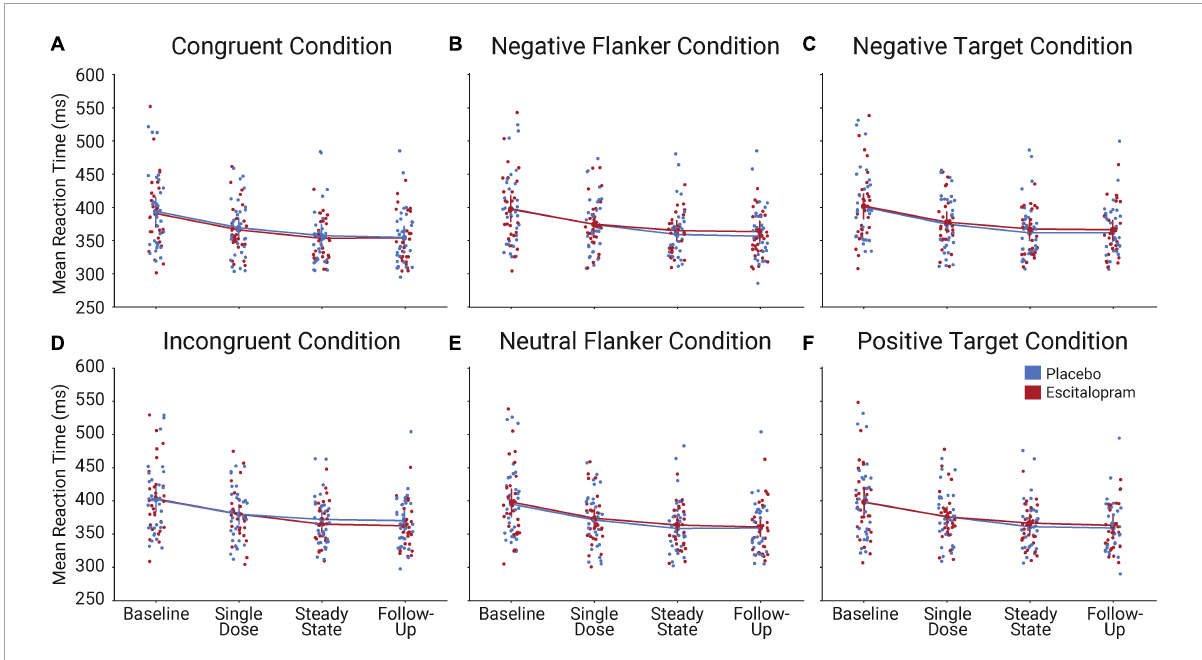
FIGURE3 Timeline of behavioral performance during 1-week of escitalopram-intake and after a 1-month wash-out period for each task condition: We measured RT [in milliseconds (ms)] performance on the mEFT in both the escitalopram and placebo groups at baseline, single dose, after 1-week of continuous intake, and following a 1-month wash-out period. We assessed performance in each of the (A) congruent and (B) incongruent conditions, (C) the negative and (D) neutral flanker conditions, and (E) the negative target and (F) positive target conditions. While results indicate a significant effect of time, with decreasing RT between the baseline and follow-up assessments, we did not observe any indication of a difference between groups on any measure of